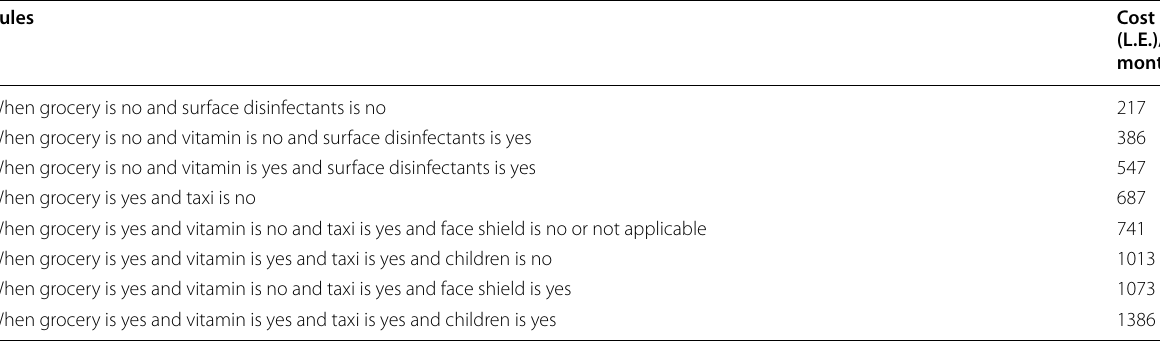
Table 5 Decision rules of the regression tree